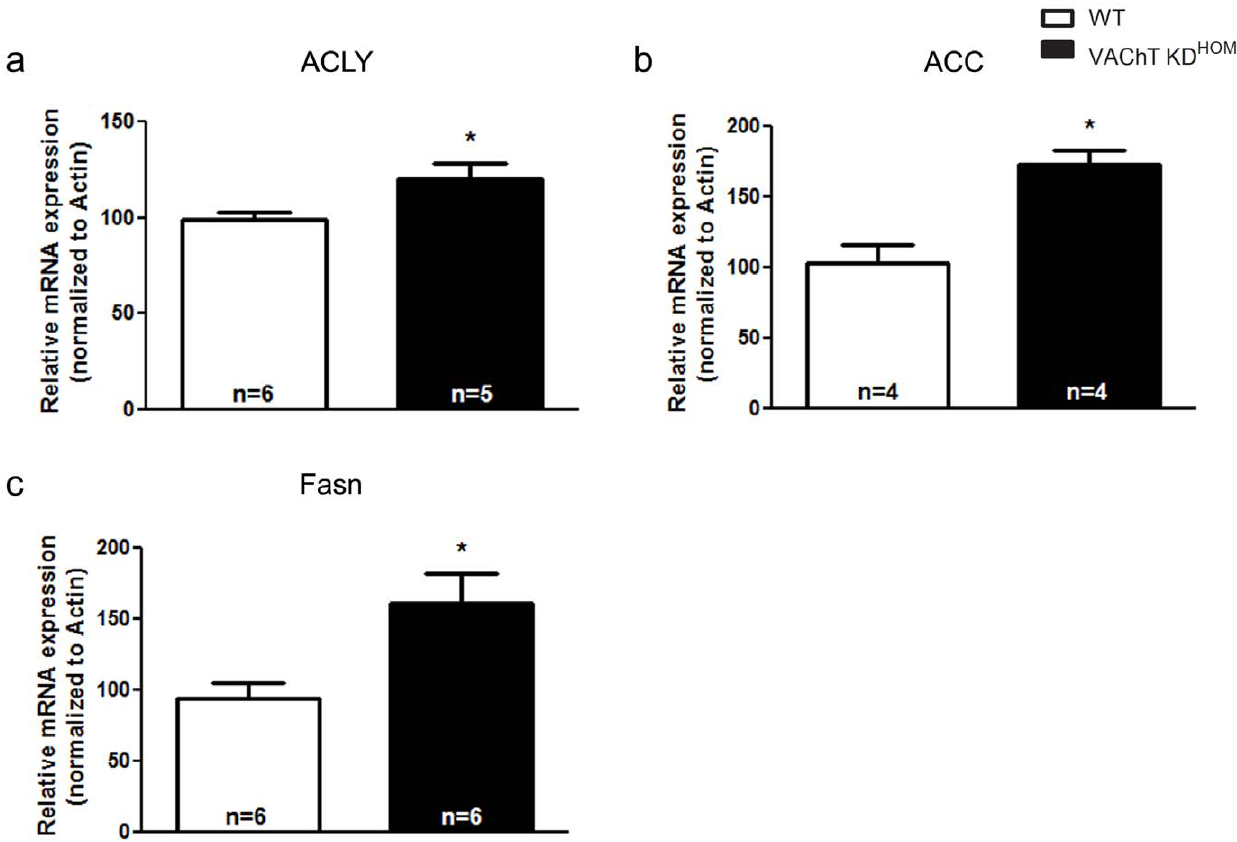
Figure 4. The transcription of genes related to fatty acid biosynthesis is upregulated. mRNA expression of ATP citrate lyase (ACLY, panel a ), Acetyl-CoA carboxylase (ACC; panel b ) and fatty acid synthase (FAS; panel c ) was increased expression in VAChT KD HOM mice. Data represent the mean 6 SEM, with n indicated within bars. *p , 0.05 versus wild-type mice.